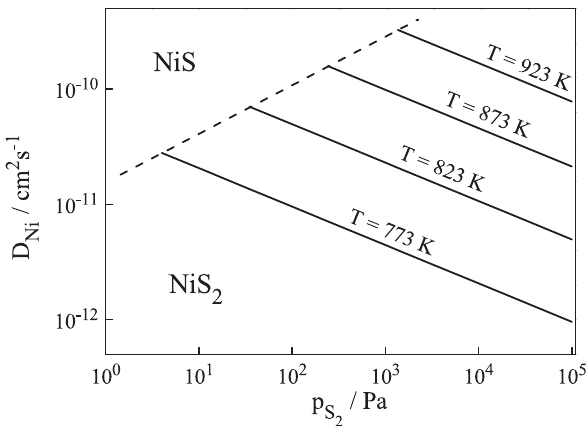
Fig. 13: The pressure dependence of the self-diffusion coefficient of cations in NiS 2 , presented in double logarithmic plot for several